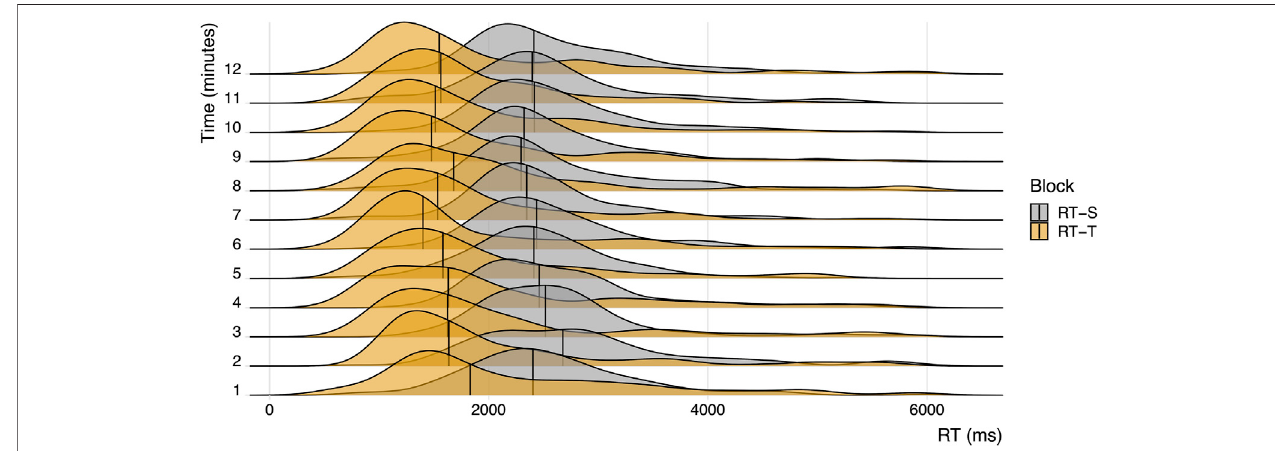
FIGURE 3 | Visual comparison of reaction times for correct trials in the RT-adaptive, typing-based (RT-T) and RT-adaptive speaking-based (RT-S) learning condition over the time course of the experiment. Vertical lines represent median reaction times at each time point.